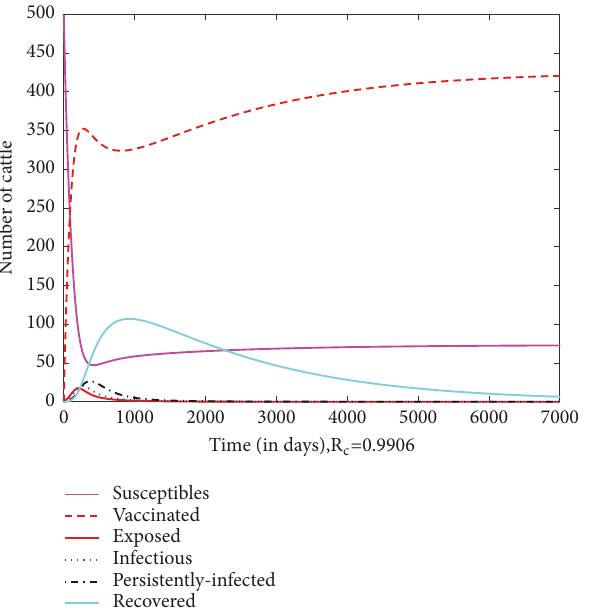
Figure 7: Number of cattle in each compartment with baseline parameter values in Table 1 with the assumption that 50 % of infec- tious cattle receive antibiotic treatment or the period of infection = 0) , 𝐼 = 1 , 𝑆 = 499 , is reduced to 28 days ( 𝛼 𝑡 = 1/28 − 1/56) , 50 % of susceptible get 𝑡 0 0 vaccinationwithin73days (𝜌 = (0.5×0.8×0.65)/73) , 𝐼 0 = 1, 𝑆 0 = 499 = 0.9906 . and 𝑉 0 = 𝐸 0 = 𝑇 0 = 𝑄 0 = 𝑅 0 = 0 , giving approximate equilibrium 𝑐 values 𝑆 ∗ = 144 , 𝑉 ∗ = 350 , 𝐸 ∗ = 𝐼 ∗ = 𝑄 ∗ = 0 , 𝑅 ∗ = 6 , and R = 0.9921 𝑐